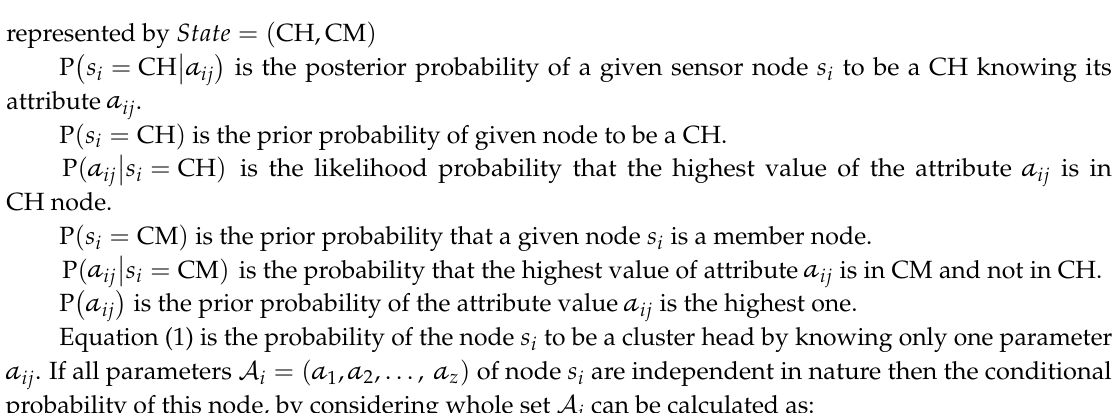
Figure 4. Dynamic clustering scheme.